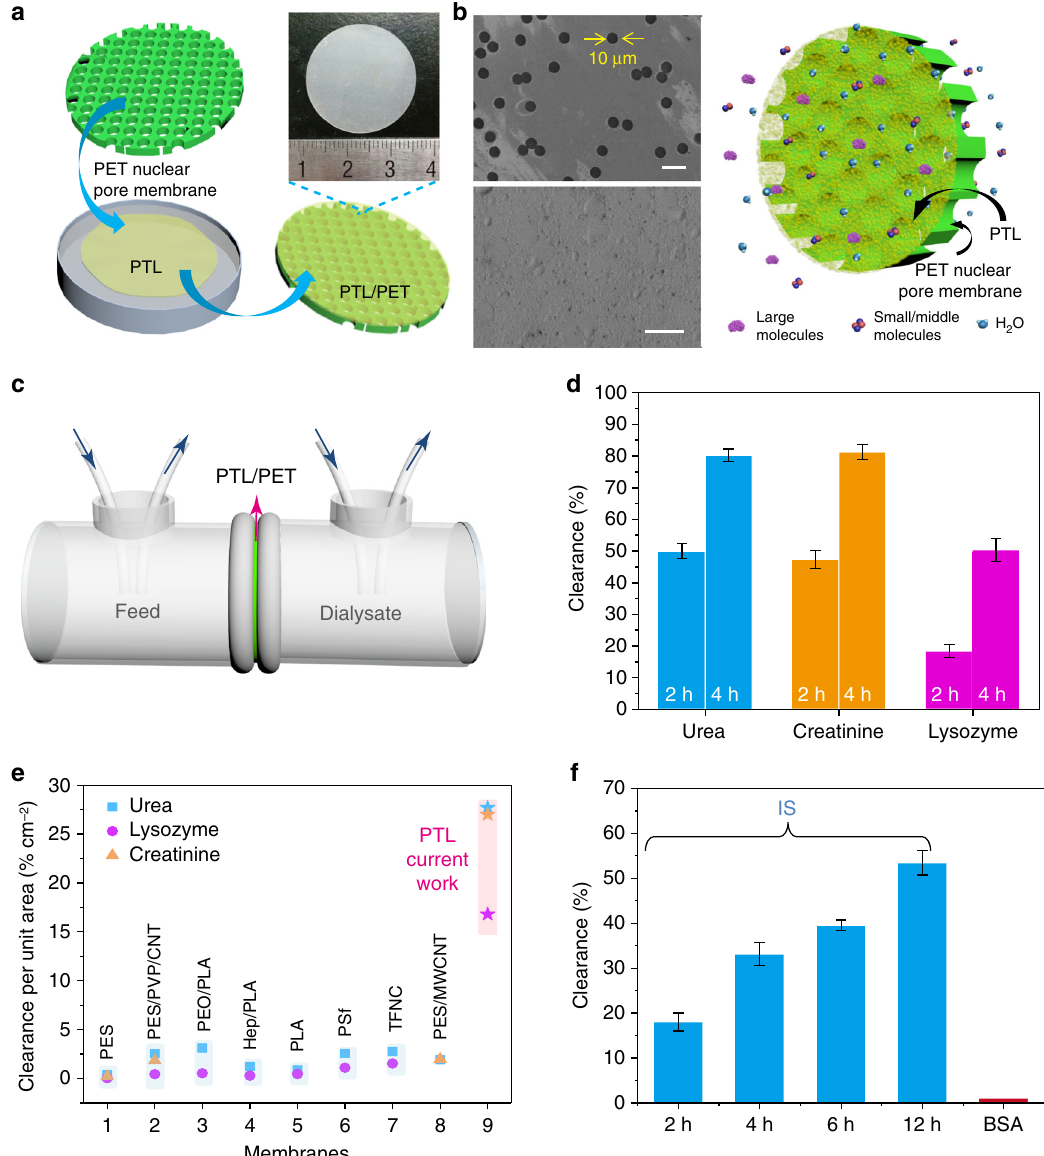
Fig. 4 The dialysis performance of the PTL membrane. a Schematic of the preparation of the PTL/PET membrane and an optical photograph of the PTL/PET membrane. b SEM images of the PET nuclear pore support before (top) and after (bottom) it was covered by the PTL membrane, scale bars, 20 μ m, as well as a schematic of an ideal hemodialysis membrane (removes excess water and toxic metabolites and prevents the loss of necessary proteins) with an active PTL separation layer and a scaffold-like PET support. c The dialysis setup including the simulated solution for dialysis on the feed side and pure water on the dialysate side. d Size-selective separation of uremic toxins by the PTL/PET membrane: urea, lysozyme and creatinine. e Comparison of the clearance ratio per unit membrane area of the PTL/PET membrane with typical literature values reported to date 49 – 53 . f The removal of indoxyl sulfate by the PTL/ PET membrane at different time. Data shown are the average of triplicates with standard